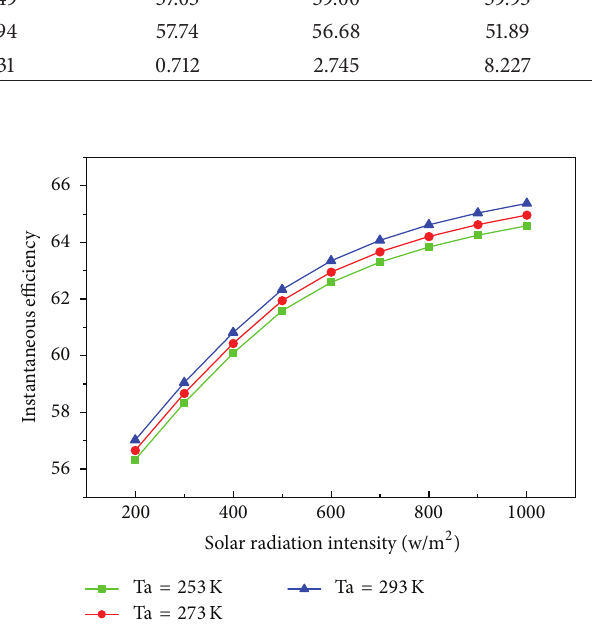
Figure 7: The influence of solar radiation intensity on the instanta- neous